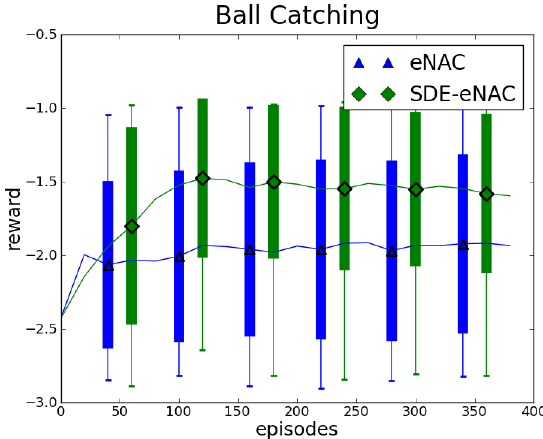
Figure 11. eNAC compared to the SDE version. Both learning curves had rel- atively high variances. While original eNAC often didn’t find a good solution, SDE found a catching behavior in almost every case, but many times lost it again due to continued exploration, hence the high